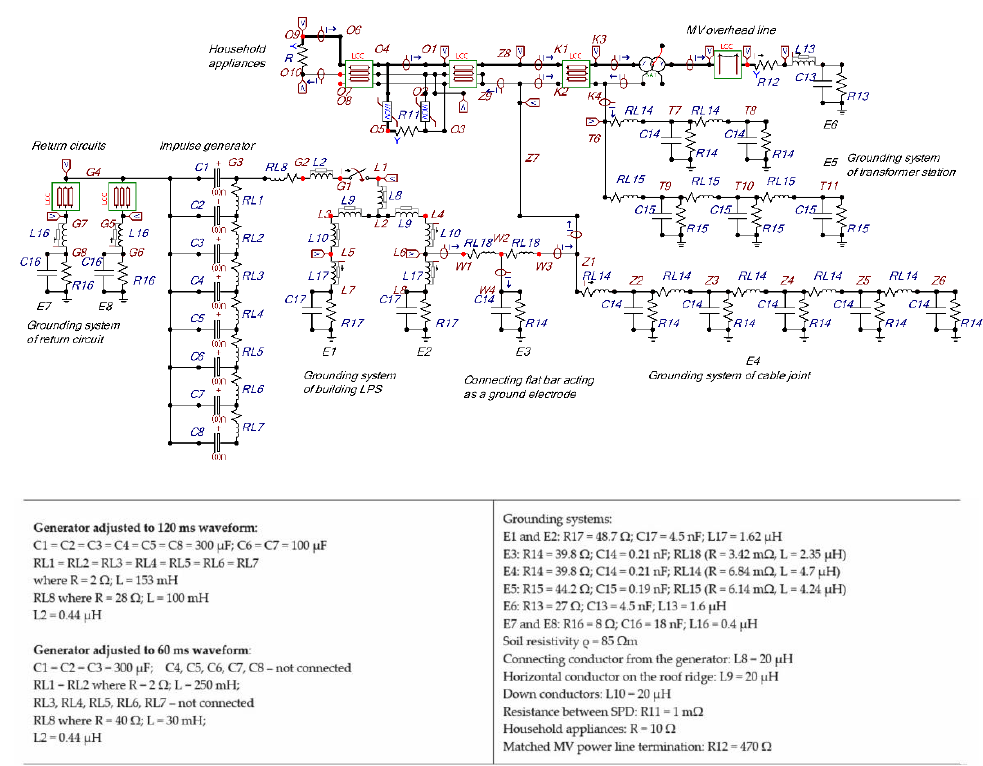
Figure 4. An improved ATP-EMTP model of the open-air test site used in [19] with another transformer model created using the SATTRAFO module and a new generator model adjusted to a pulse length of 120 ms which enables to analyse lightning continuing current distribution in the entire system. Parameters of the generator circuit configuration for a 60 ms pulse is also listed to illustrate the principle of its operation.